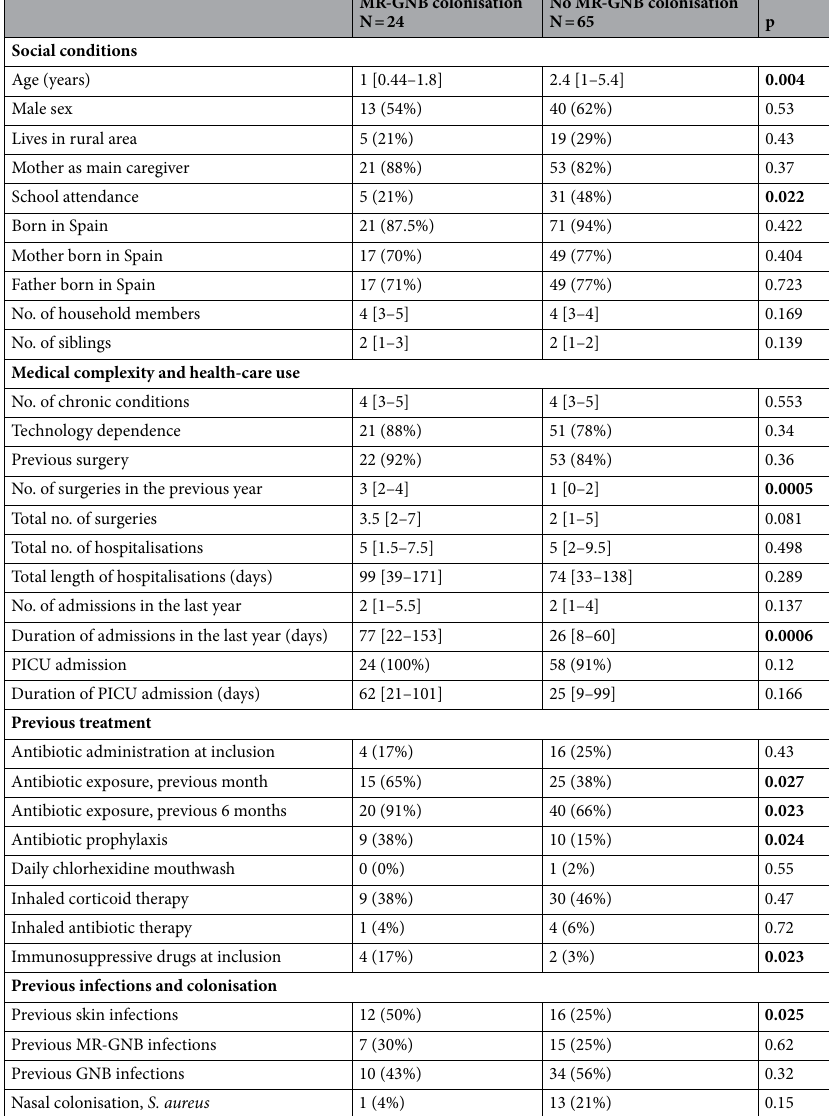
Table 2. Factors associated with multidrug-resistant Gram-negative bacilli colonisation in children with chronic complex conditions. PICU, paediatric intensive care unit; MR-GNB, multidrug-resistant Gram- negative bacilli. Significant values are given in bold.